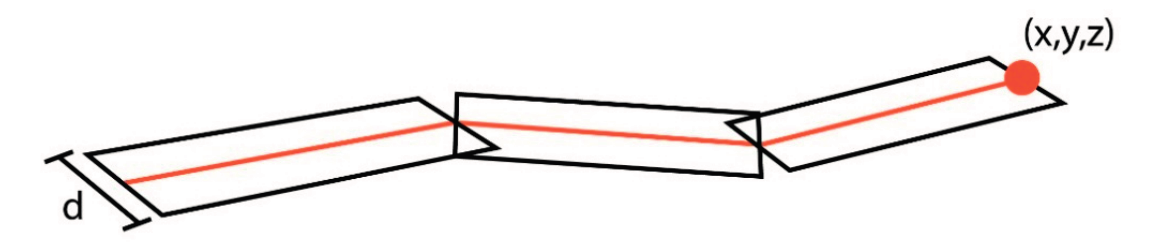
Figure 3. Single road model containing several segments, with the original road line marked in orange, showing the width (d) and the origin of the mesh model coordinate system